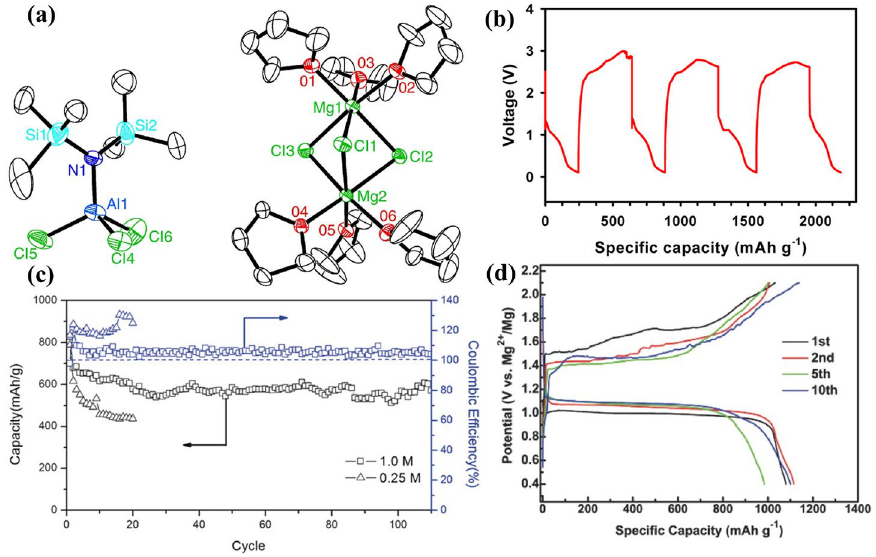
Figure 13. ( a ) Crystal structure of [Mg 2 ( µ − Cl) 3 · 6THF][HMDSAlCl 3 ] and corresponding ( b ) charge − discharge curves [11]. ( c ) Long − term cycling of Mg − S cells with MgTFSI 2 − MgCl 2 /DME electrolyte [35] . ( d ) Charge − discharge curves of Mg − S cells with BCM electrolyte at 0.05 A·g − 1 [93] .